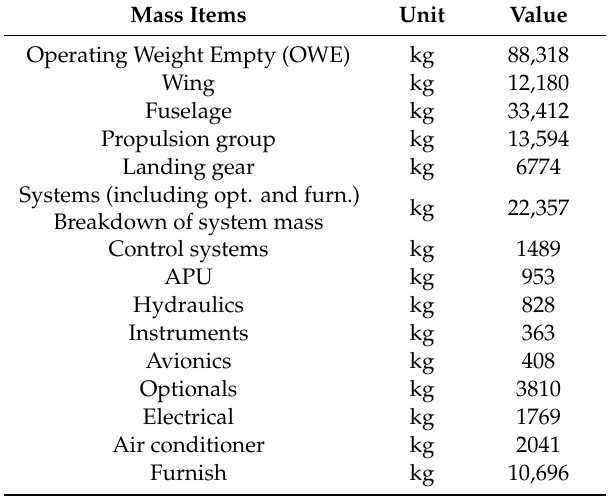
Table A3. Weight break-down of SE²A-LR calculated using SUAVE after optimization.